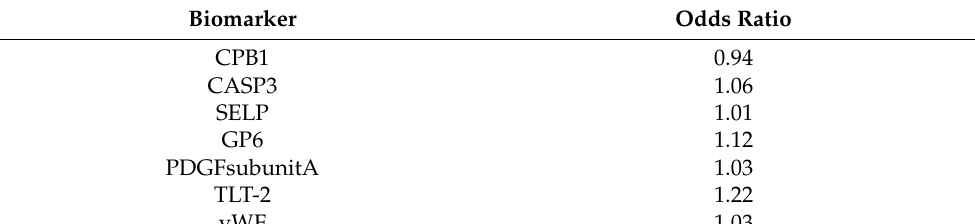
Table 3. Odds ratios of the Z-scores of the biomarkers selected by the elastic net regression.